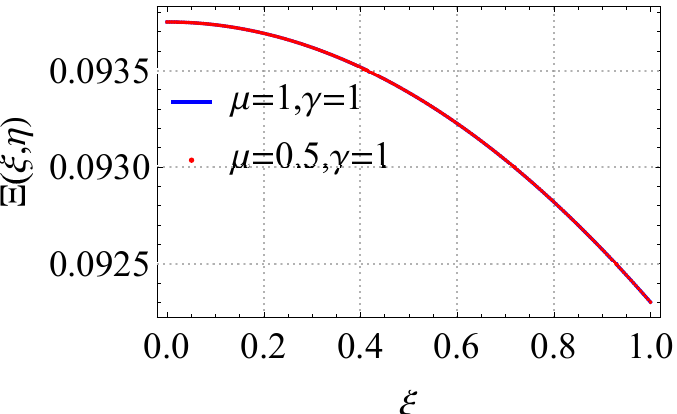
Figure 5. Graph of the solution of Model 3, with α 2 = 2.7, α 1 = 0.7, T = 1, m = 5 and τ = 0.00001, and for different values of µ and γ